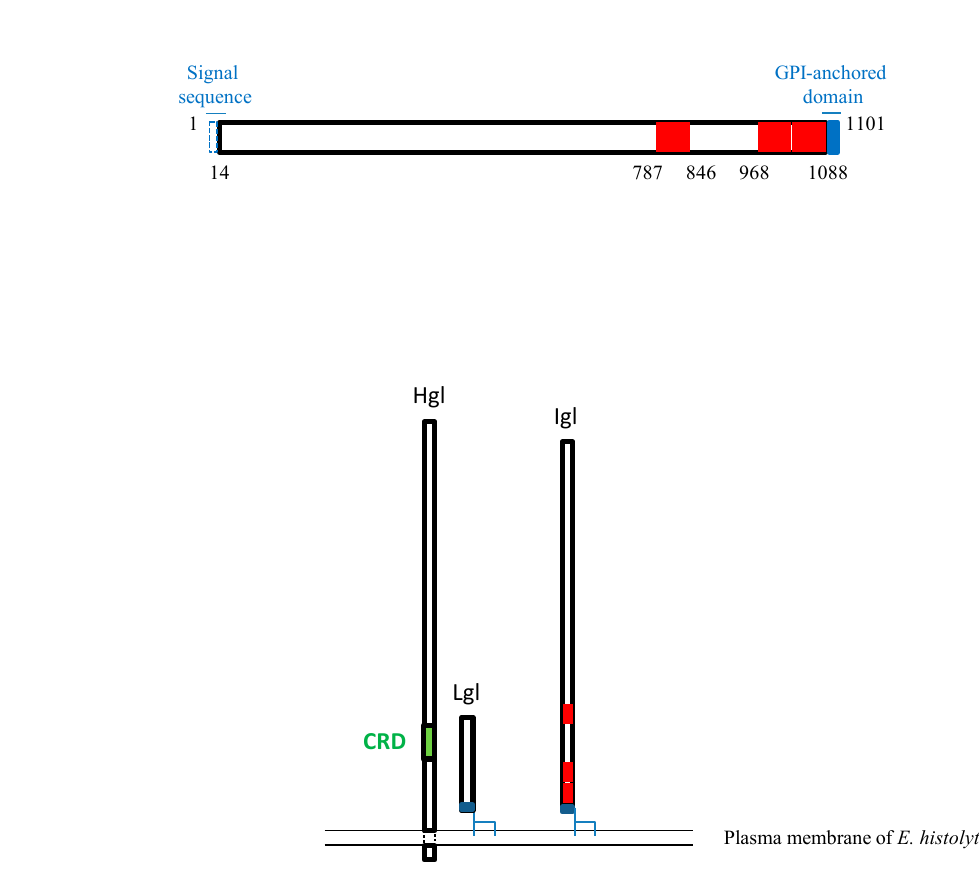
Figure 6. Amino acid sequences of Igl1 fragments. ( A ) Sequence alignment of Igl1 fragments with hemolytic and cytotoxic activities. Asterisks indicate common amino acids. ( B ) Sequences of Igl1 fragments without these activities. The Igl1 sequence refers to protein ID AAK92361. Cysteine resi- dues are shown in red and proline residues are shown in bold.